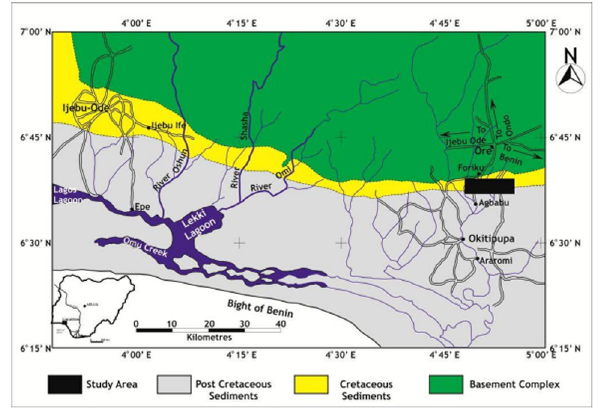
Fig. 2 Geologic map of the outcrop sections of the Nigerian Heavy Oil and Natural Bitumen